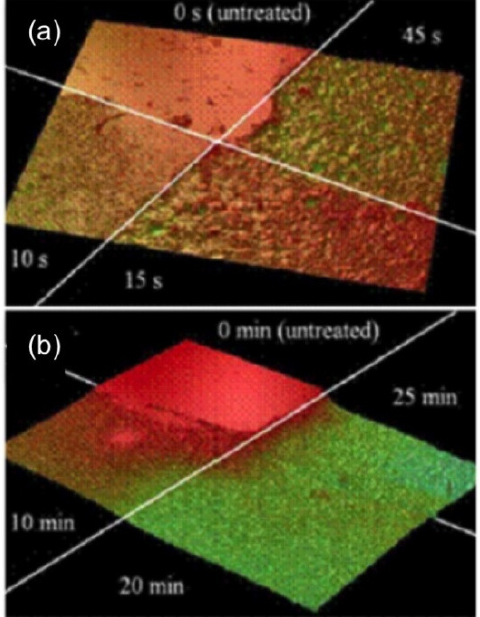
Figure 9. Optical Profiler analysis of citric acid induced dental enamel erosion